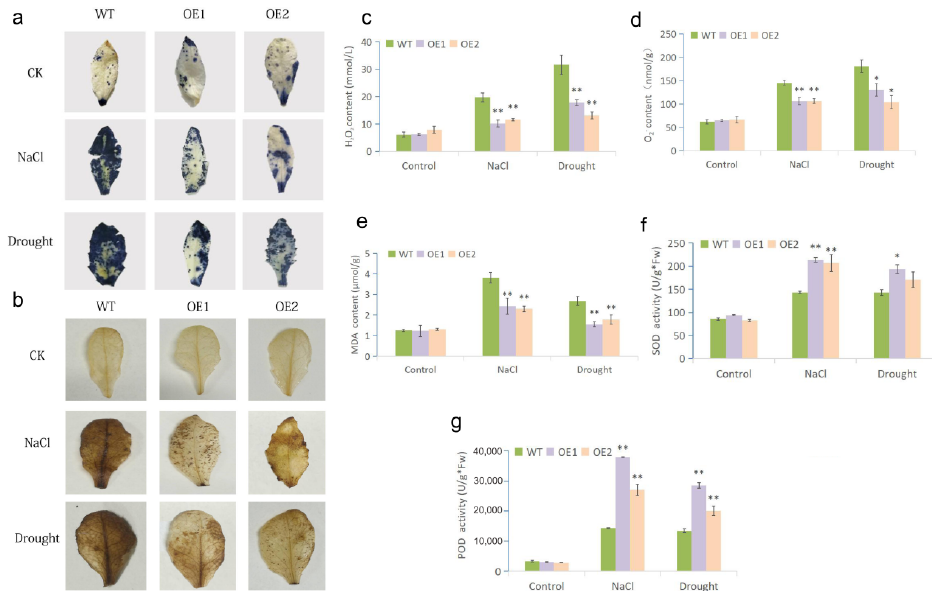
Figure 5. Analysis of oxidative damage and ROS scavenging ability under drought and salt treatments. Histochemical staining with DAB ( a ) and NBT ( b ) were used to detect the accumulation of H 2 O 2 and O 2 − . ( c , d ) showed the quantification of H 2 O 2 and O 2 − contents of OE and WT plants before and after stress treatments, respectively. ( e – g ) indicated the MDA content and activities of SOD and POD in the leaves of OE and WT plants, respectively. Samples used for staining and measurements were leaves of plants treated by drought (stopping watering 4-week-old plants for 10 days) and salt (irrigating 4-week-old plants using 300 mM NaCl solution for 7 days) stresses. Each measurement was performed in three replicates. Data were presented as mean and SD values of three independent experiments. Asterisks indicated significant difference (* p < 0.05, ** p < 0.01, by Student’s t -test) between WT and OE lines.